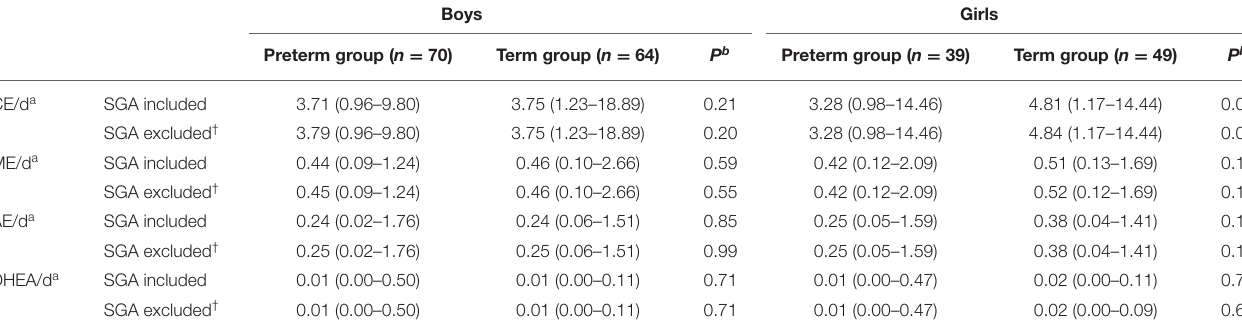
TABLE 3 | Adrenal steroid metabolites in children born preterm and children born at